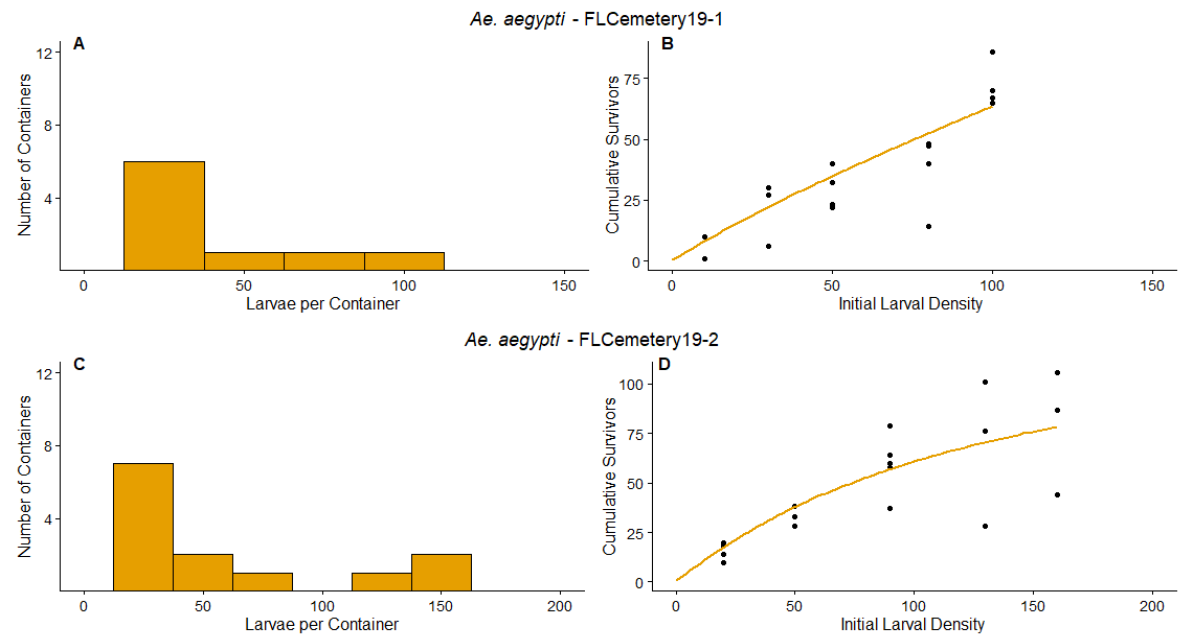
Figure 5. Results for FLCemetery19-1 and FLCemetery19-2 experiments. The left panels are the frequency distributions of mosquito larvae per container at the end of the survey periods, ( A ) for FLCemetery19-1, ( C ) for FLCemetery19-2. The points on the right panels represent the cumulative number of survivors of the density manipulation experiments, ( B ) for FLCemetery19-1, ( D ) for FLCemetery19-2. The lines on the right panels represent the predicted values for the relationship between initial larval density and cumulative survivors, according to the non-linear regression analyses. Orange indicates the experiment was conducted on Ae. aegypti . Axis values vary between experiments.